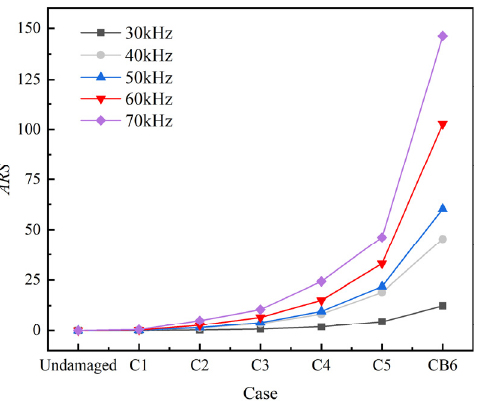
Figure 16. Sum of residual square of main frequency signal in time domain.